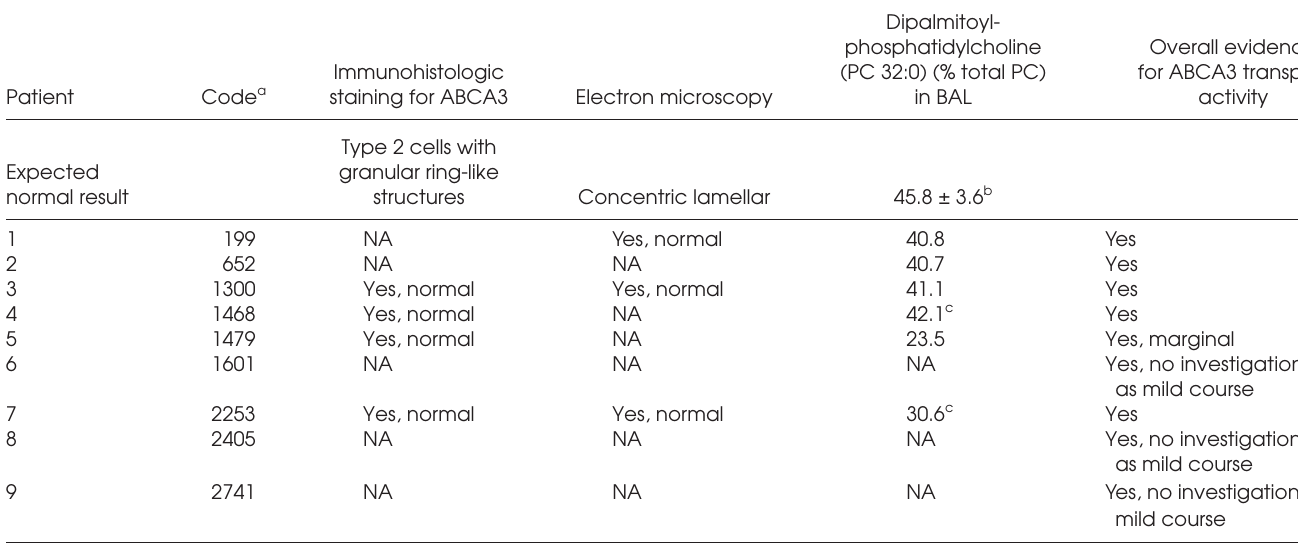
table 2. Ex vivo evidence for functionality of ABCA3 transport activity.